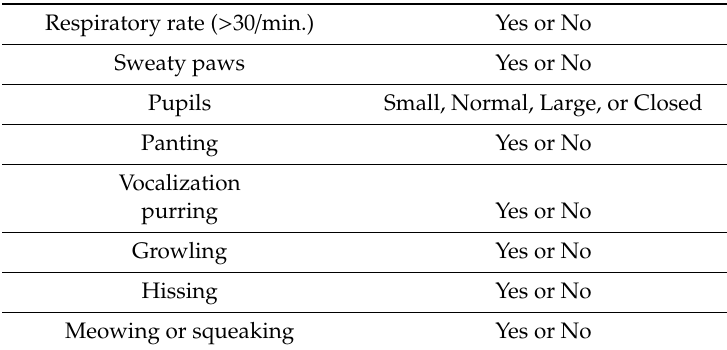
Table 1. Stress reaction